Question: In a single sentence, describe what this figure presents.
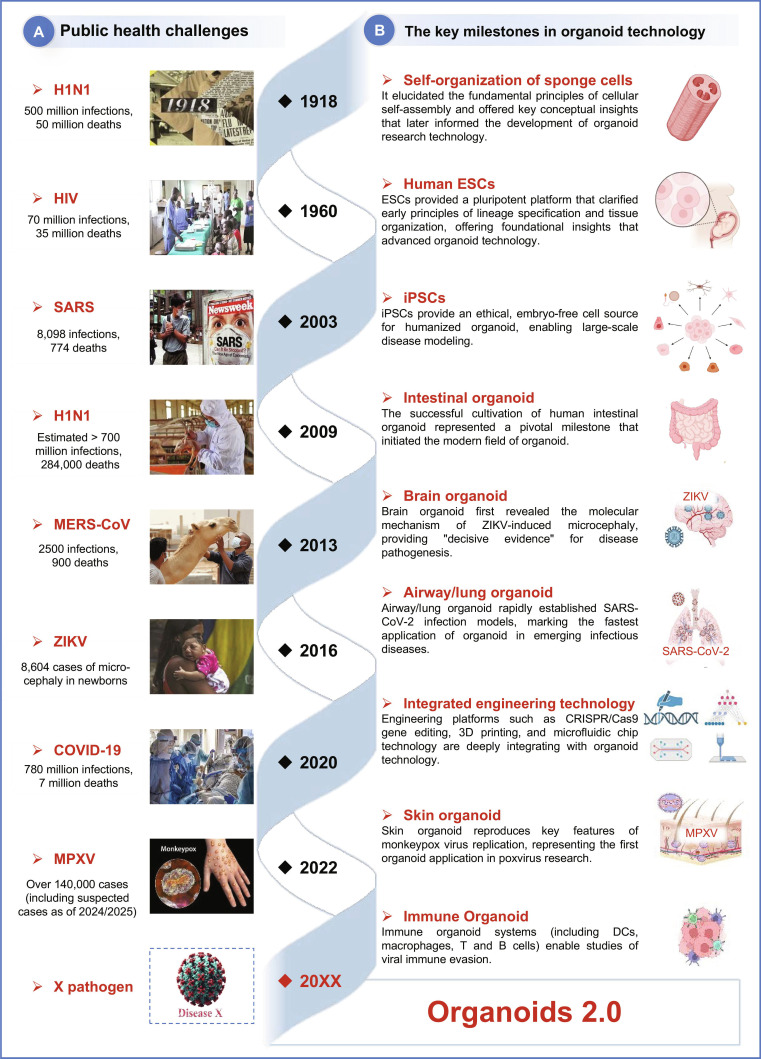
Answer: The convergence of public health threats and organoid research breakthroughs. (A) Chronological overview of major global infectious disease outbreaks and their prevalence since 1918. (B) Timeline highlighting pivotal milestones in organoid research and key engineering technologies in pathogen biology. Created with BioRender.com .